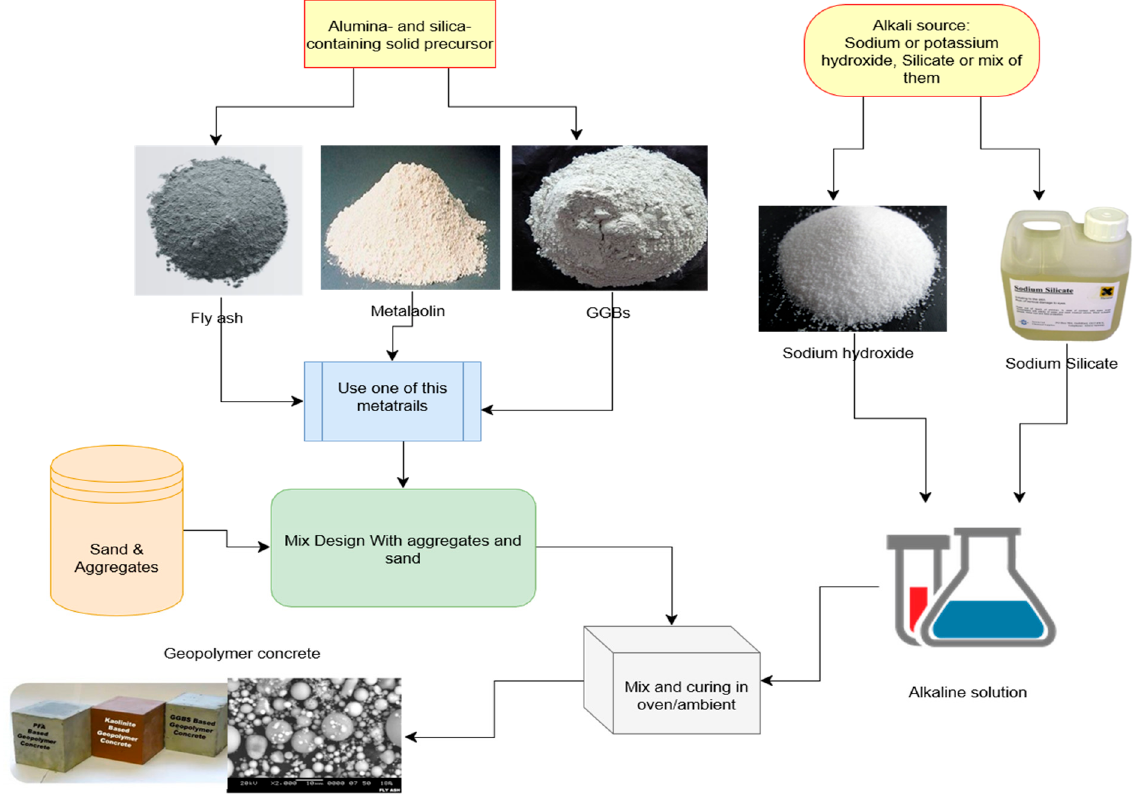
Figure 4. Geopolymer concrete production